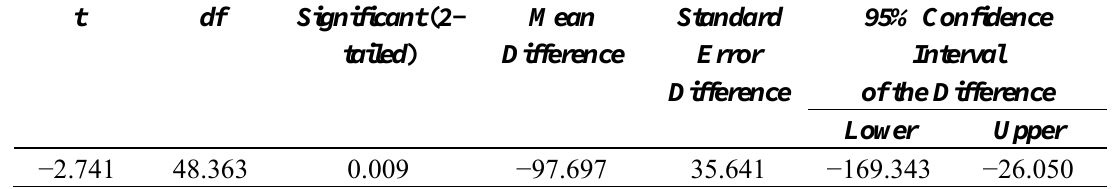
Table 12. T - test on speed of retweeting of post with sentiment linking photos vs . videos